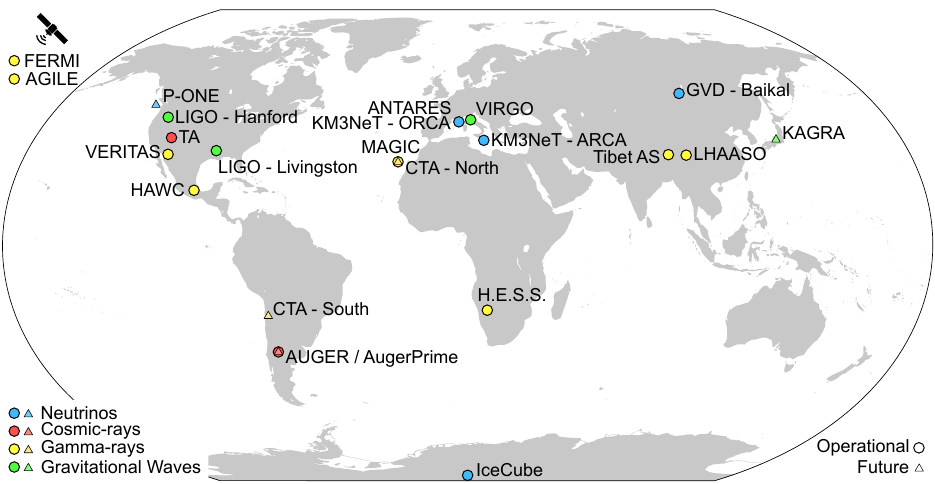
Figure 1. Earth map indicating the location of a selection of multimessenger observatories that are either currently operating (circles) or planned (triangles). Satellites are depicted outside to the